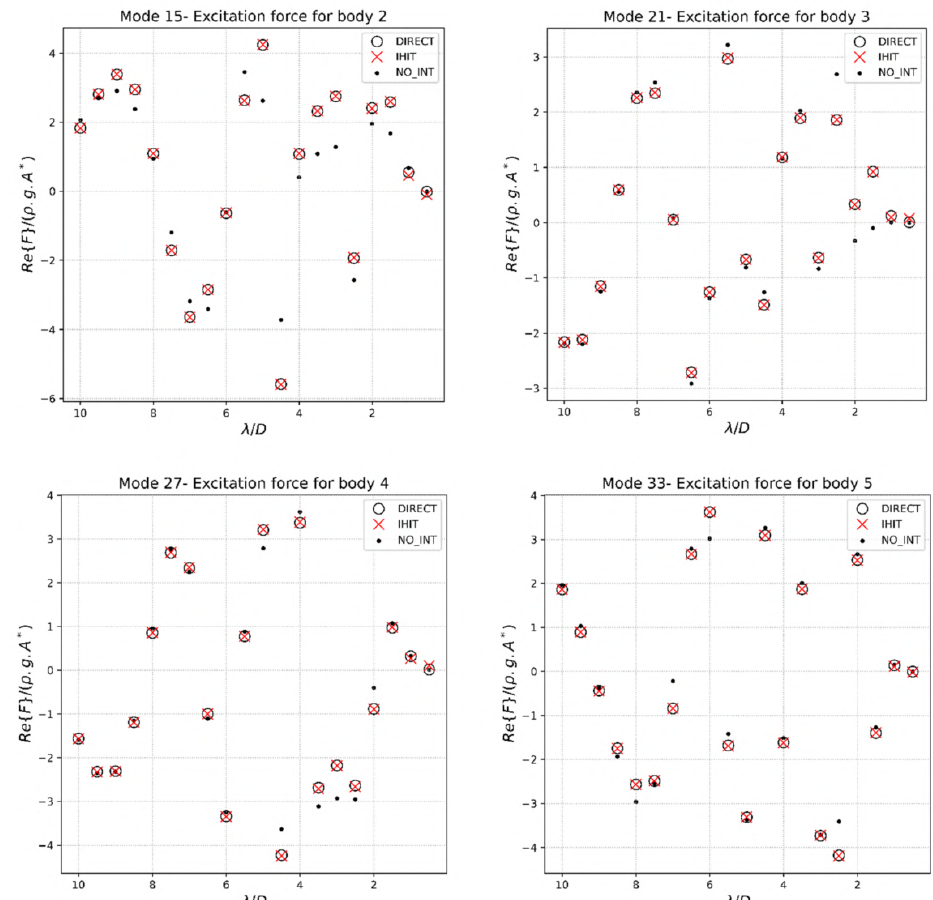
Figure 4. Real part of the excitation forces in heave for each body. “DIRECT”, “IHIT”, and “NO_INT” denote the solution using WAMIT with the direct method, the solution using the interaction theory with inhomogeneous wave field, and the solution for a single isolated body using the direct method and body W 1 , respectively. F , ρ , g , and A* , stand for the excitation force, the fluid density, the standard gravity acceleration, and the heave amplitude of body W 1 , respectively.